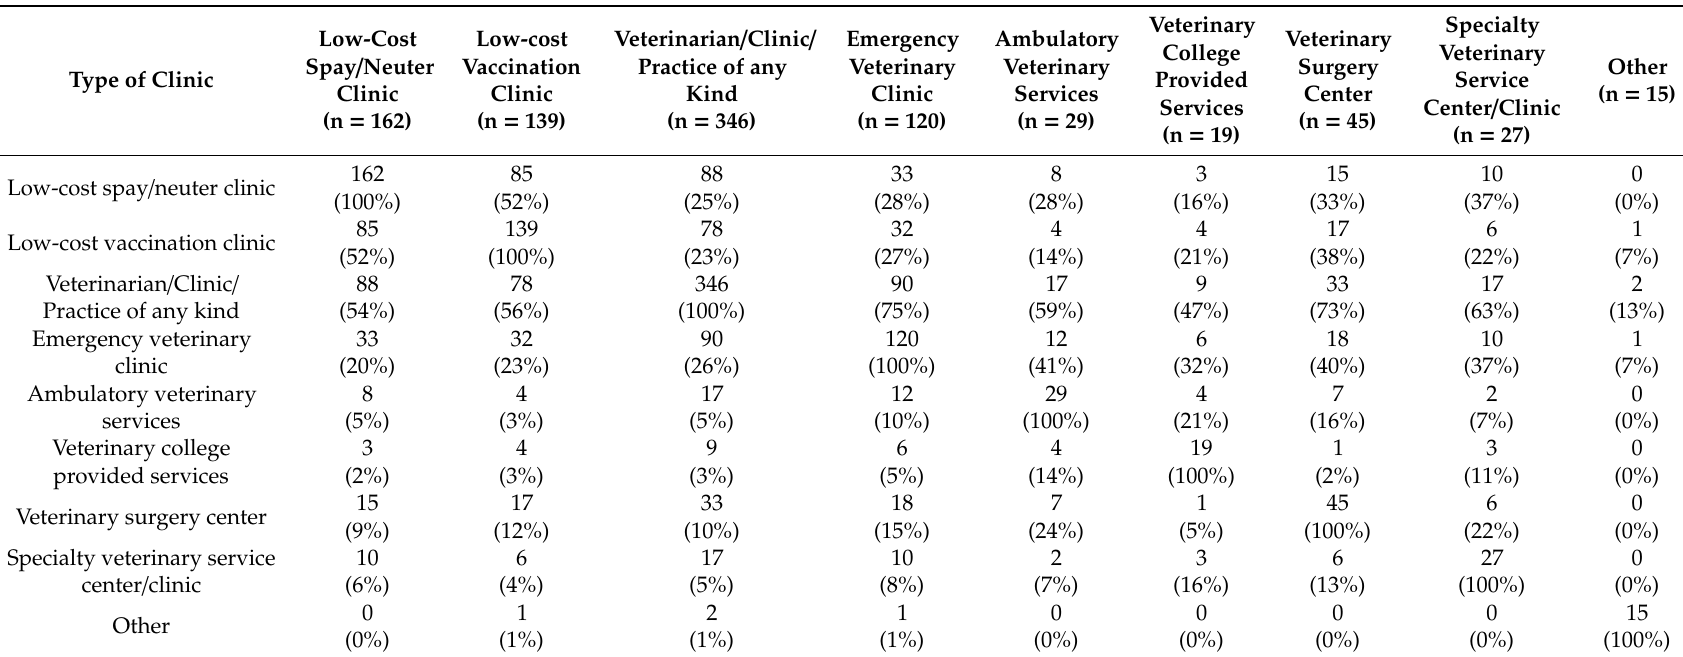
Table 4. Percentage of respondents who used multiple veterinary service options for their dog, reported number and percentage of respondents who indicated they used each type of veterinary